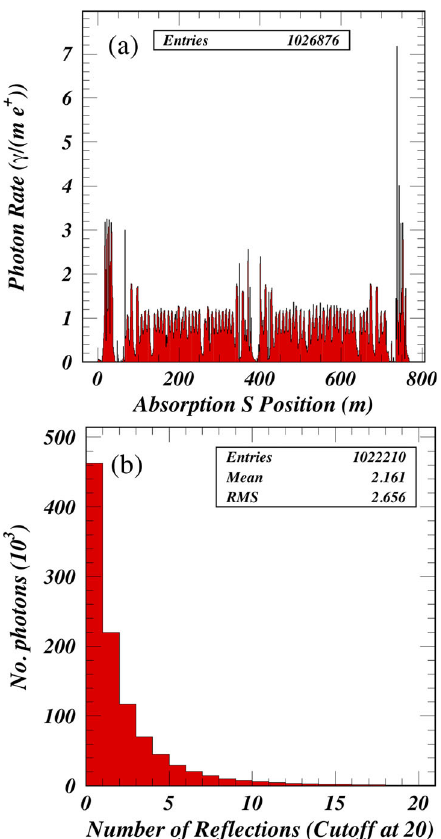
FIG. 9. Distributions of absorbed photons in (a) absorption location along the CESR ring, and (b) number of prior reflections. (Beam energy is 5.3